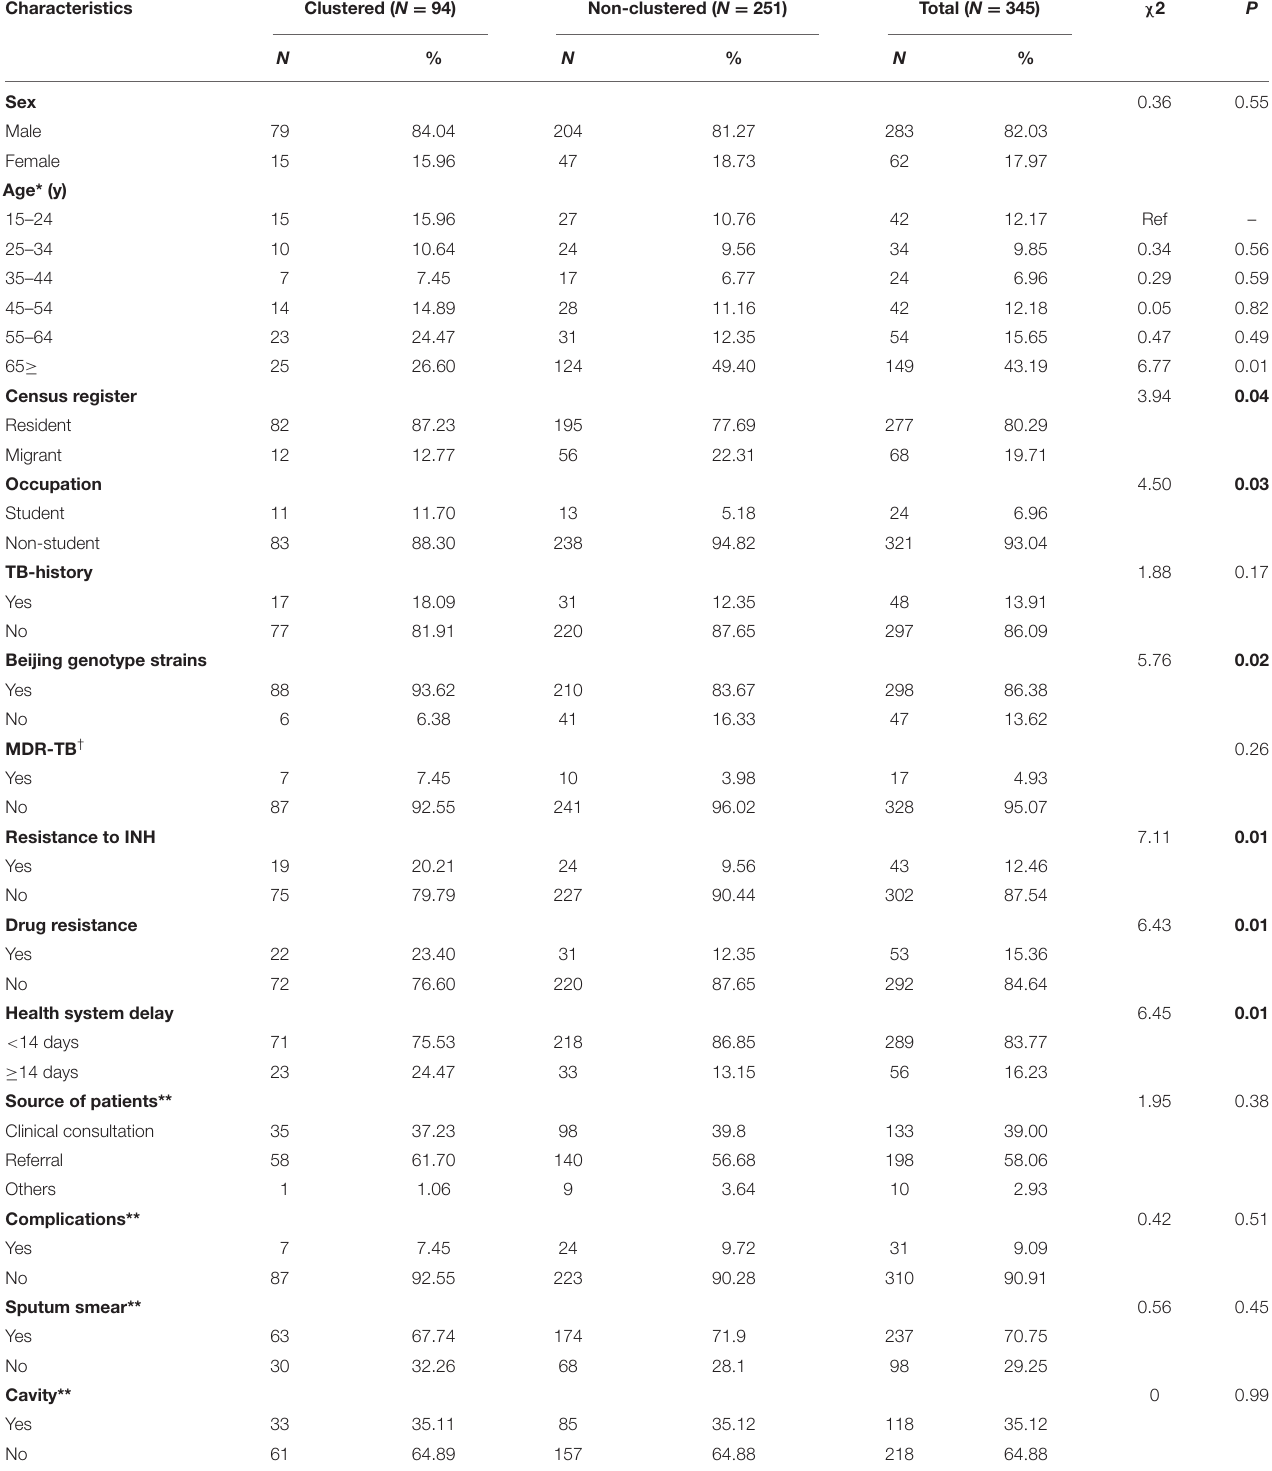
TABLE 2 | Demographic, bacteriological, phenotypic resistance, and clinical characteristics of genomic clustered and non-clustered cases in Shanghai, China, 2009–2018. Characteristics Clustered ( N = 94) Non-clustered ( N = 251) Total ( N =